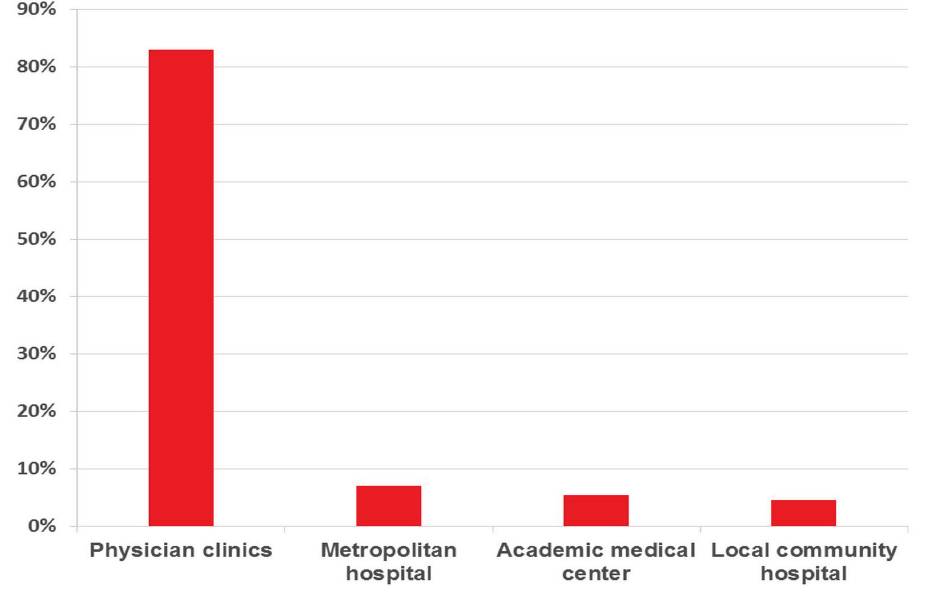
Figure 3. Pediatricians’ affiliation, stratified according to healthcare facility accreditation, data from Taiwan’s National Health Insurance in 2012 (sampling rate: